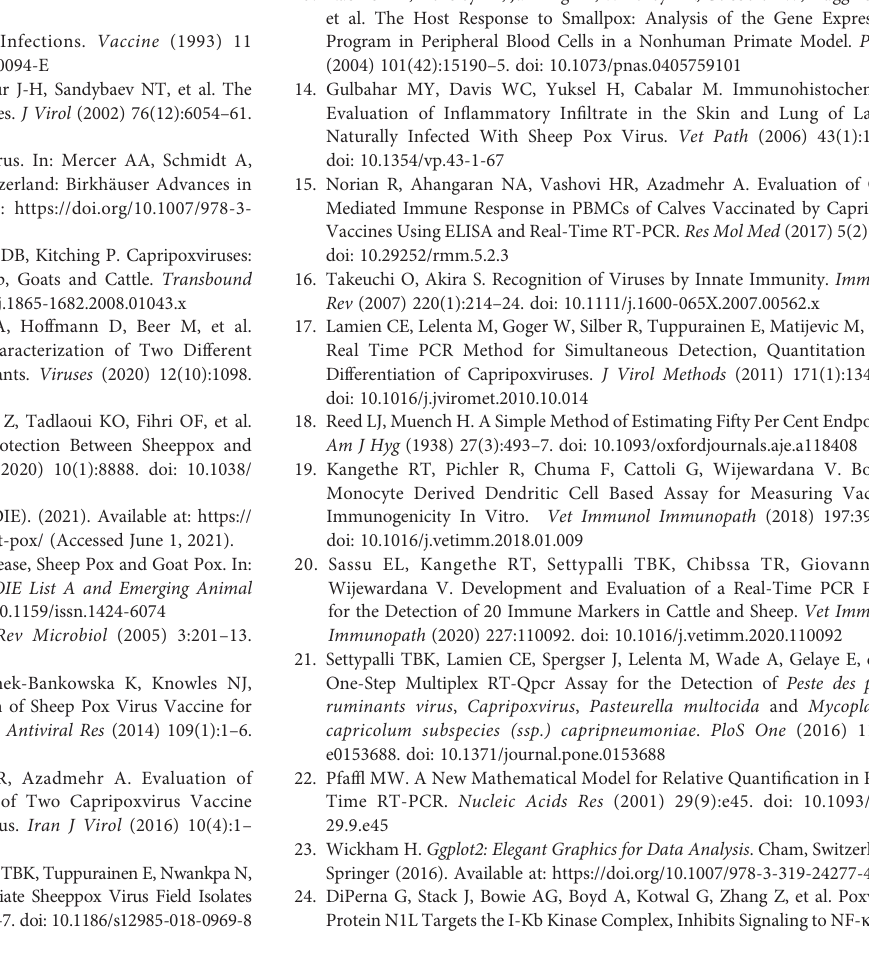
Supplementary Figure 1 | Ortholog modeling of N1L from SPPV Djelfa. Structural comparison between (A) N1L proteinofVaccinia virus (PBD 2I39)and (B) SPPVDjelfaorthologpredictedmodel, (C) Overlayofbothstructures, (D) Sequence alignment of N1L protein from different poxviruses. Supplementary Figure 2 | Sequence alignment of E3 protein from different poxviruses. Supplementary Figure 3 | RIG-1 expression in CD14- cells. The expression of RIG-1 was signi fi cantly upregulated in CD14- cells. Note that the expression RIG-1 was similar in WT when compared to LAV. Data represent the Log2 FC of fi ve independent